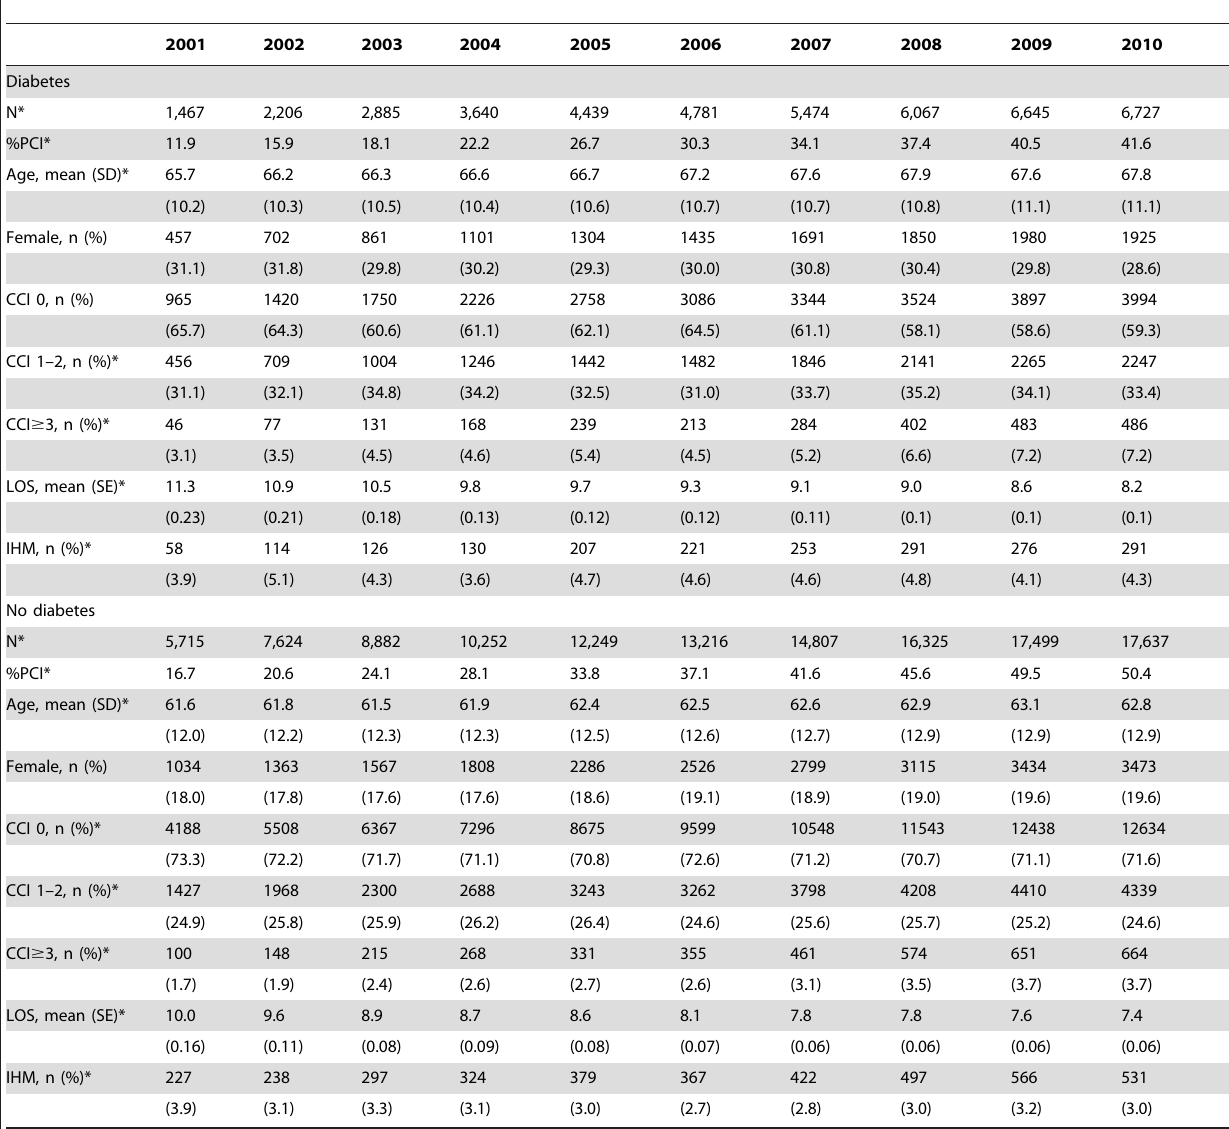
Table 3. Characteristics and outcomes of hospital discharges after percutaneous coronary intervention among patients with and without type 2 diabetes in Spain,